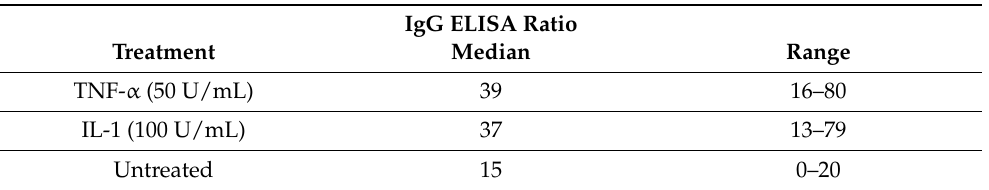
Table 5. Enhanced binding of anti-endothelial cell antibodies (AECAs) to cytokine-treated HUVECs in AECA-positive samples from patients with